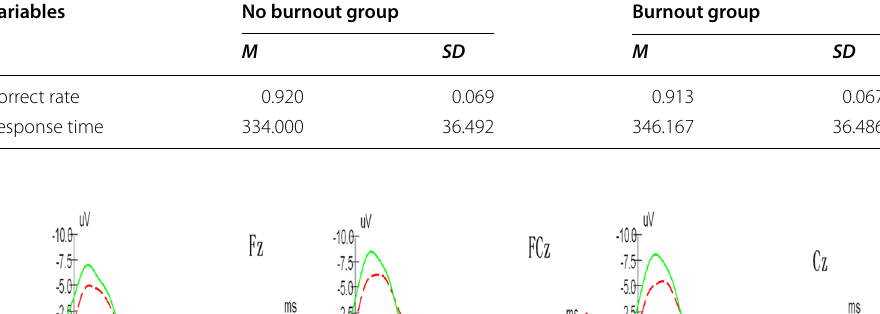
Table 4 Correct rate and correct response time of college athletes with and without burnout Variables